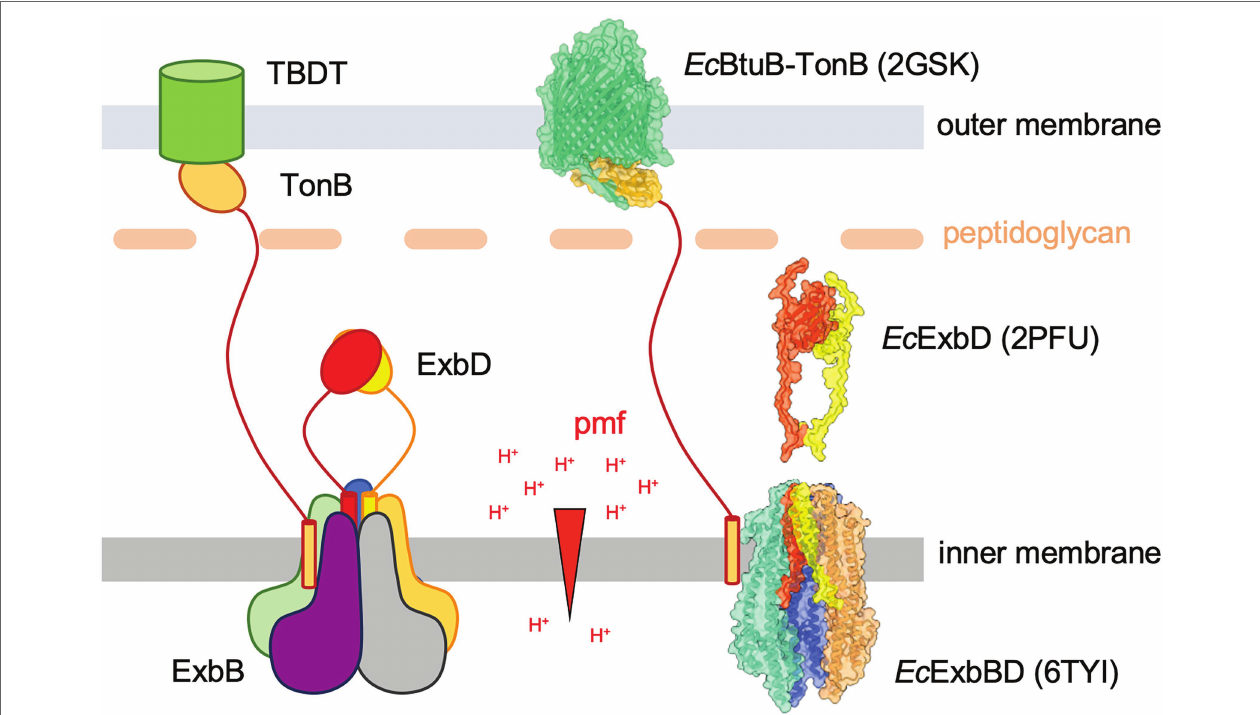
FIGURE 1 | A schematic representation of the Ton uptake system (left) and molecular models of the different components (right). Left panel: the TonB-dependent transporter (TBDT, green cylinder) is anchored in the outer membrane (OM). The ligand binds on the extracellular face of the TBDT and exposes a conserved domain called the TonB box to the periplasmic side. The TonB–ExbB–ExbD (TBD) complex is anchored in the inner membrane (IM) and uses the proton motive force (pmf, proton gradient across the IM, symbolized with the red arrowhead) to generate force and movement. The TBD complex is made of a pentamer of the ExbB subunit (blue, orange, grey, purple, and green) that defines a central pore in which a dimer of ExbD subunits (red and yellow) resides. The TonB subunit (gold) binds at the periphery of the ExbBD subcomplex. The elongated periplasmic domain of TonB allows its C-terminal globular domain to reach the OM and form a stable interaction with the TBDT TonB box. It is hypothesized that the ExbBD subcomplex forms the proton channel and that the energy derived from proton translocation is propagated through the TonB subunit to the TBDT, eventually opening a channel into the TBDT and allowing the bound ligand to diffuse into the periplasm. Right panel: molecular representations of known components of the Escherichia coli Ton system. The structural models are shown with ribbons and molecular surfaces. The color coding is the same than for the schematic view on the left. The TM and flexible periplasmic domain on the Ec TonB subunit are not known and shown as in the schematic representation. The crystallographic structure of Ec BtuB (green) in complex with the Ec TonB periplasmic domain (gold) is represented in the OM (pdb 2GSK; Shultis et al., 2006). Two models of the NMR structure of the Ec ExbD periplasmic domains are shown in red and yellow (pdb 2PFU; Garcia-Herrero et al., 2007). The cryo-EM structure of the Ec ExbBD complex is shown in the IM (pdb 6TYI; Celia et al., 2019). The grey and purple ExbB subunits are not represented in order to show the ExbD TM domains. Molecular graphics have been performed with UCSF ChimeraX (Pettersen et al.,